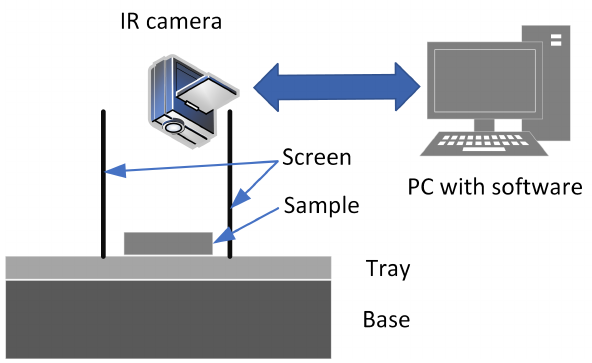
Figure 6. Measurement set-up for IR images acquisition.